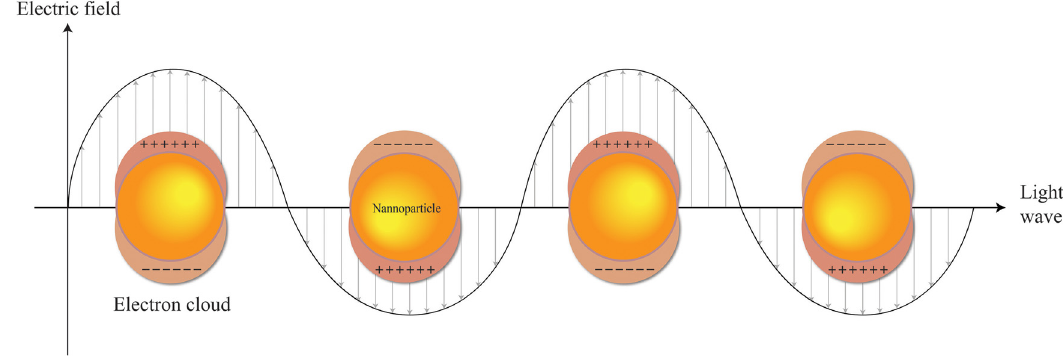
Figure 7: Schematic of LSPR where incident light caused the free conduction electrons in the metal NPs to collective